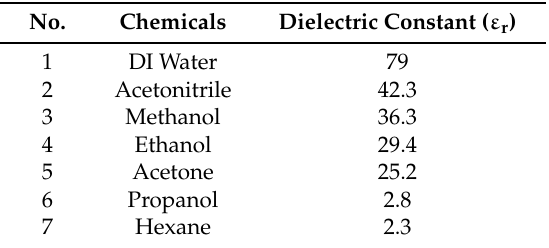
Table 2. Extracted dielectric constants of chemicals in 13–18